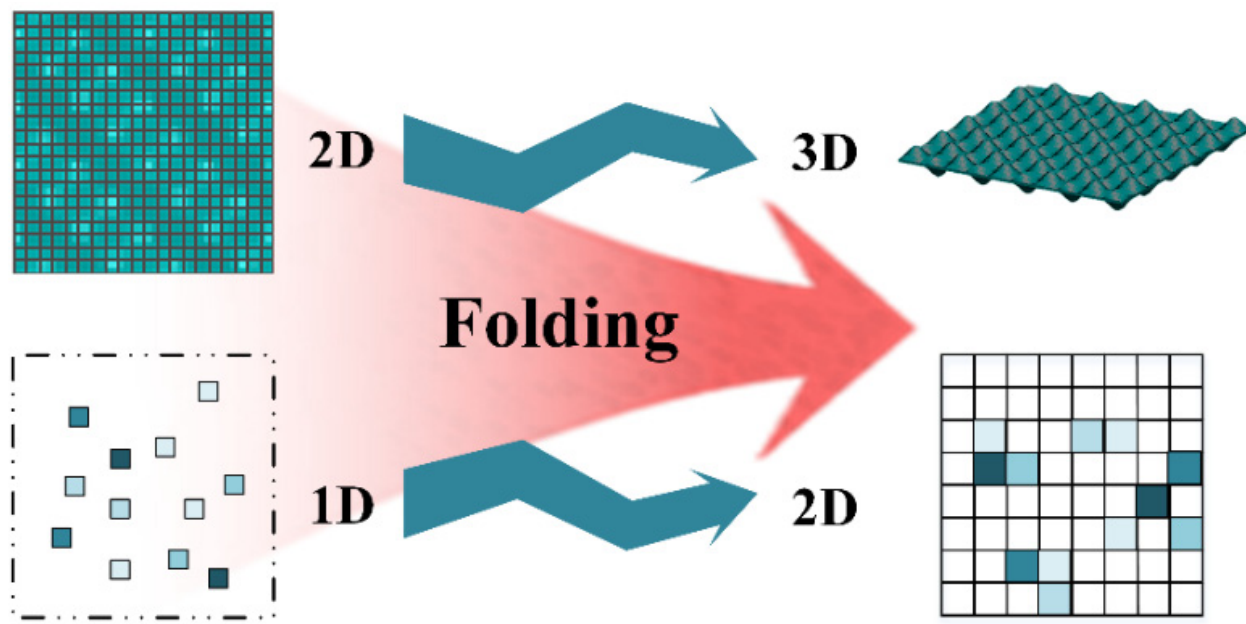
Figure 4. The schematic diagram of the point folding module. The top line is a folding network for point cloud completion, which folds 2D random grid points into 3D shapes through neural network learning to complete point clouds. The bottom row is our proposed folding network for depth completion, which folds 1D random discrete points into 2D grid points through neural network learning to complete depth information.